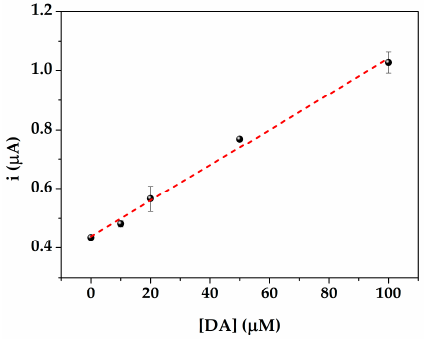
Figure 7. Dopamine detection in 40-fold diluted serum performed with different DA concentrations (0–100 μ M). Each point was obtained at least five times using different sensors. The %RSD, calculated using at least five measurements with different SPEs, was 2%. These results confirmed the suitability of the use of the proposed nanocomposite sensor for the determination of DA in serum analysis.